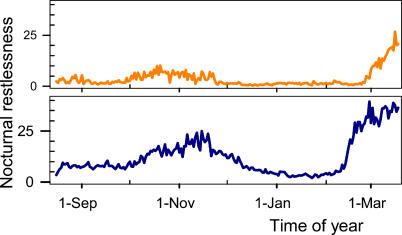
Zugunruhe under European Day Length ConditionsCurves show mean nocturnal activity of ten resident African (upper panel, orange line) compared to 26 migrant European (lower panel, blue line) stonechats kept individually for one migration period under simulated natural European day length conditions; for details, see
Figure 1.